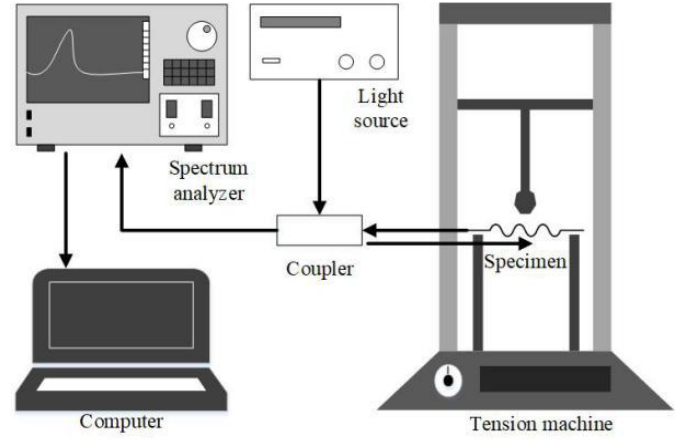
Figure 2. Diagram of the test system.